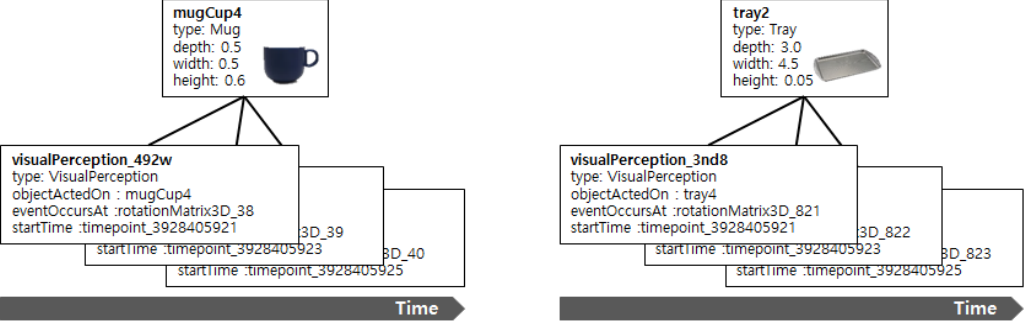
Figure 2. An example of visual perceptions.